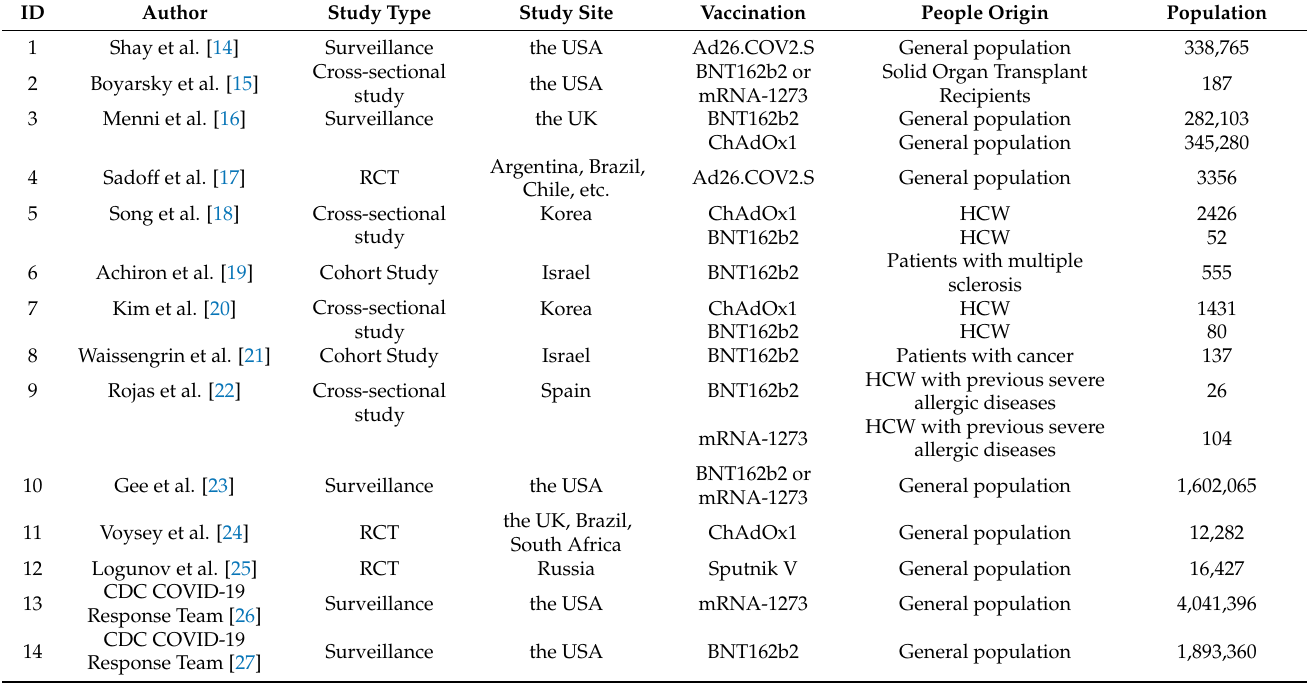
Table 1. Basic information of the included literature.